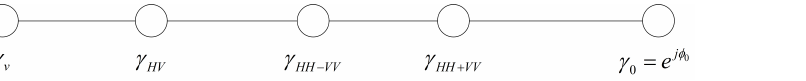
Figure 1. The relative location of coherence values in different polarization states along the best- fit